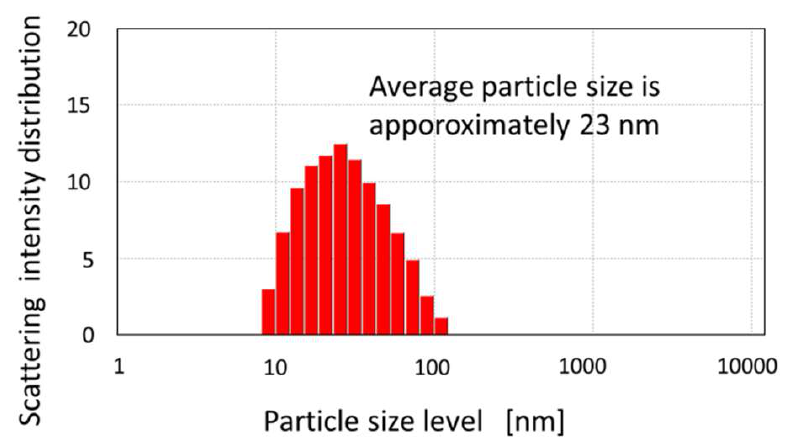
Figure 8. Particle-size distribution of the Pt nanoparticles.